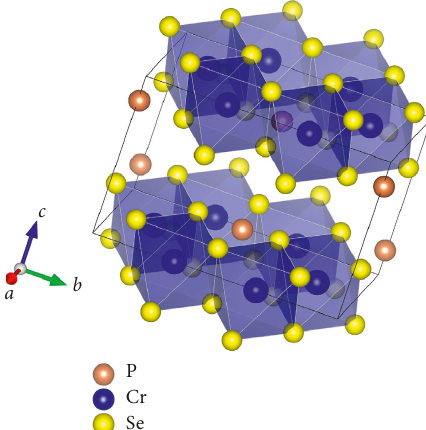
Figure 2: Visualization of the unit cell of PCrSe